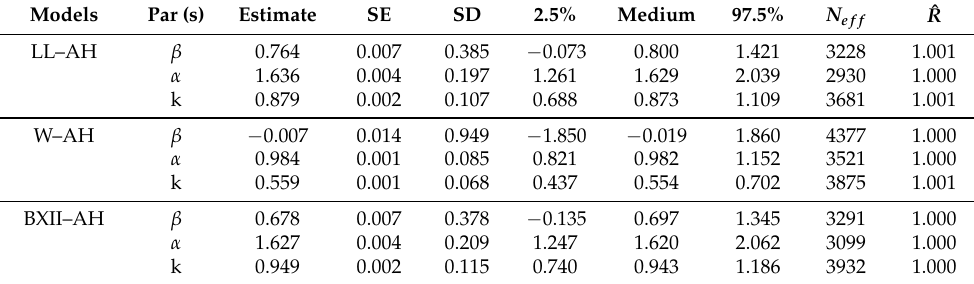
Table 6. Results for the posterior properties of the submodels of the GLL–AH model including LL–AH, W–AH, and BXII–AH